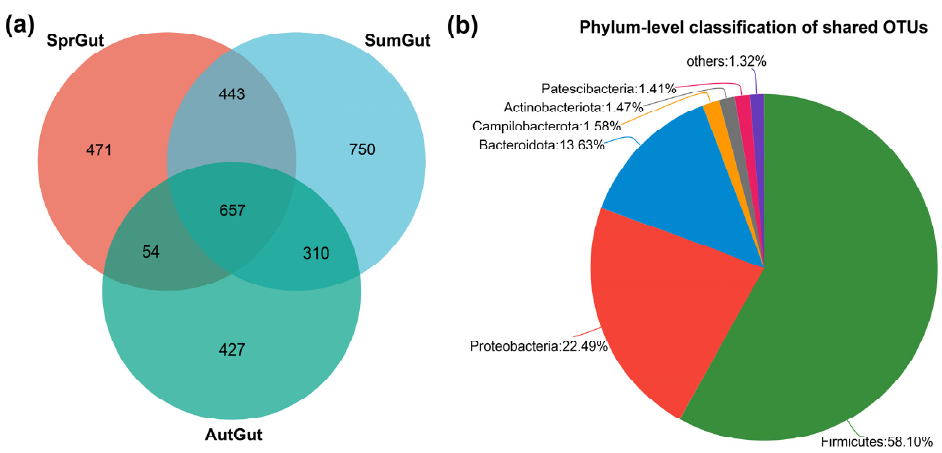
Figure 5. Venn diagram based on OTU level in the studied seasons ( a ) and classification of shared OTUs at the phylum level ( b ).